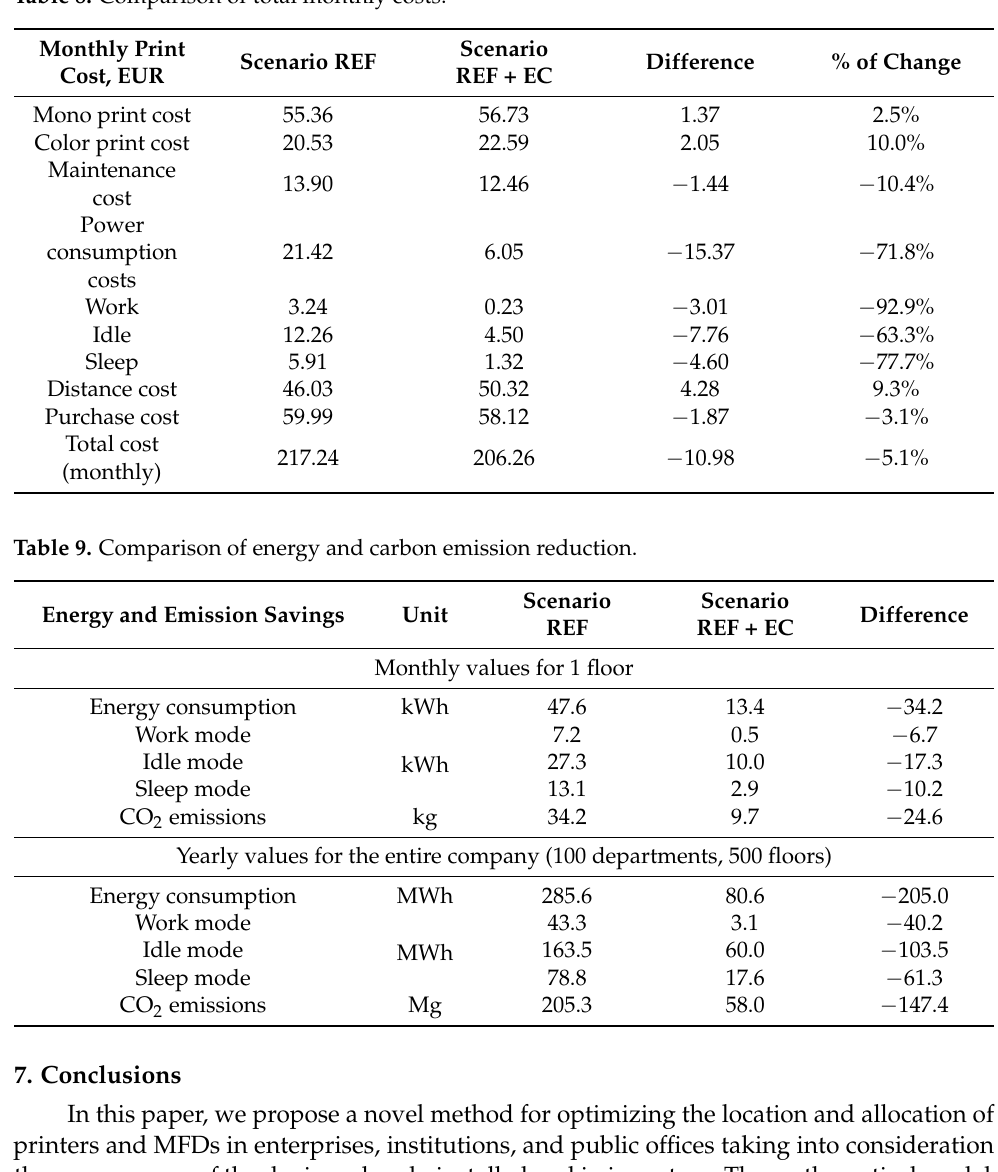
Table 8. Comparison of total monthly costs.